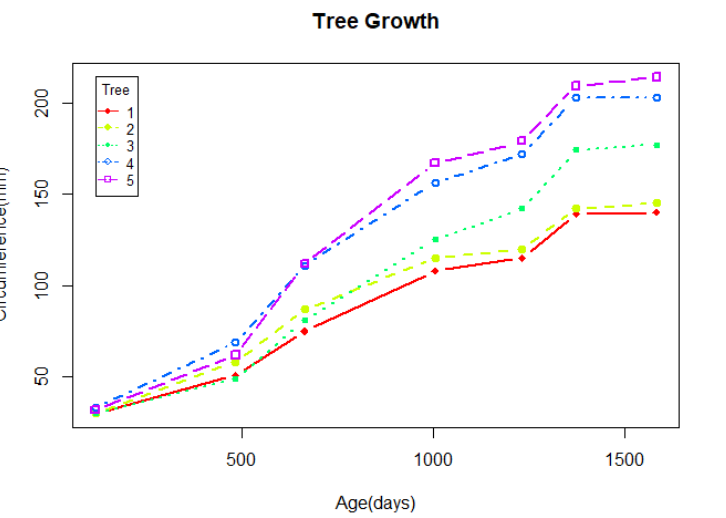
Figure 3. Trunk circumference (in millimeters) of five orange